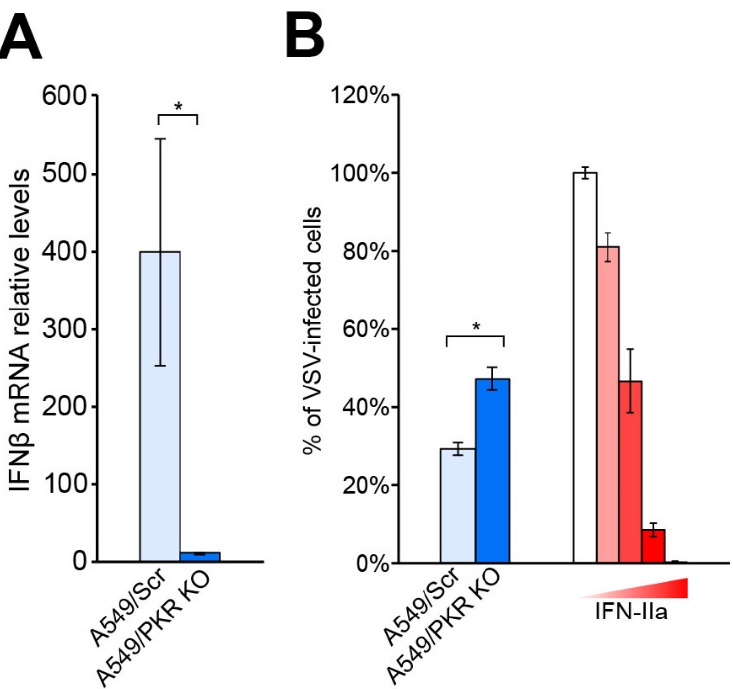
Figure 1. ( A ) IFN- β mRNA expression in A549/Scr and A549/PKR KO cells infected with TCRV. Cells were infected at MOI 0.01 PFU/Cell with TCRV, total RNA was collected 5 days after infection and subjected to RT-qPCR as described in Materials and Methods. Fold-induction was calculated by the 2 - ΔΔ Ct method. Error bars represent standard deviations ( n = 6). ( B ) Detection of IFN activity by bioassay. Conditioned supernatants from TCRV-infected A549/Scr and A549/PKR KO cells were UV inactivated for 2 min and used to pretreat VeroE6 cells for 16 h. As a positive control, we used titrated amounts of IFN-IIa (10 4 , 10 3 , 10 2 , 10, and 0 IU/mL) diluted in supernatant from uninfected cells. Pretreated cells were infected with VSV (300 PFU/well). Values were normalized to samples in absence of IFN. Error bars represent standard deviations ( n = 3) of results from one representative experiment out of two independent experiments. * stands for p value < 0.001 in an ANOVA test.